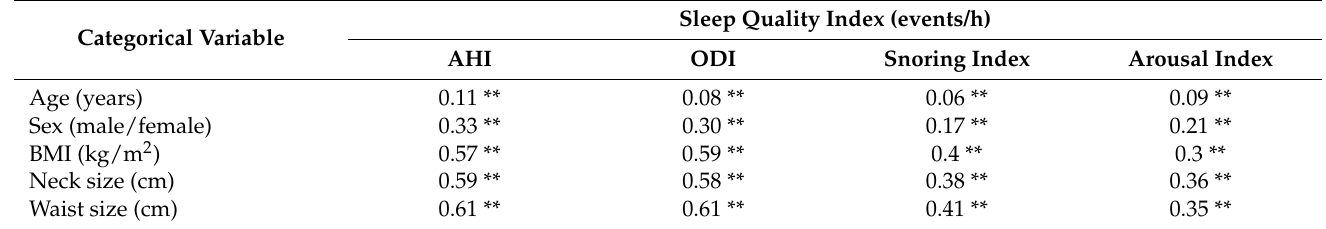
Table 3. Pearson’s correlation coefficients for polysomnography parameters and body composition